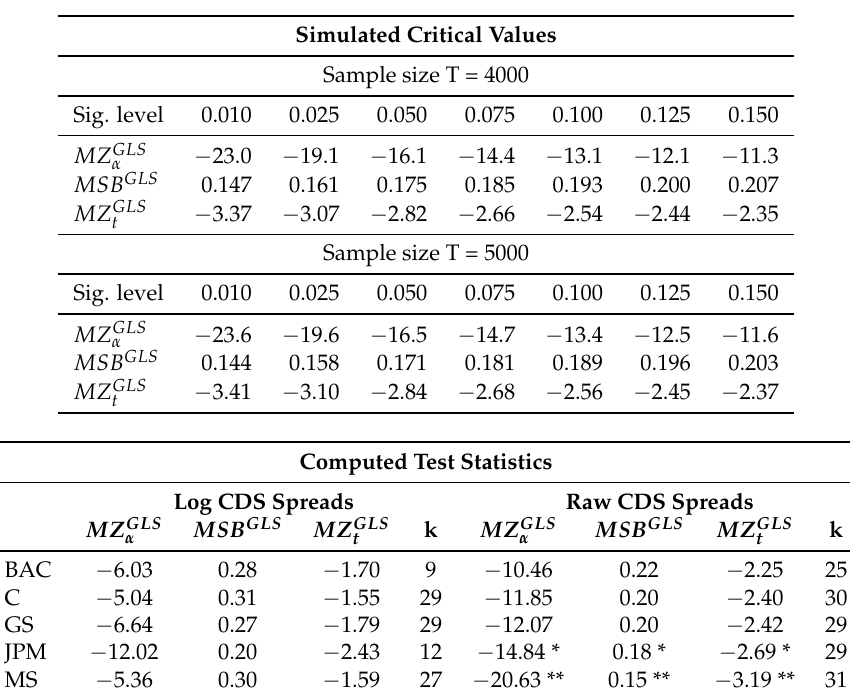
Table 2. Ng and Perron’s M GLS